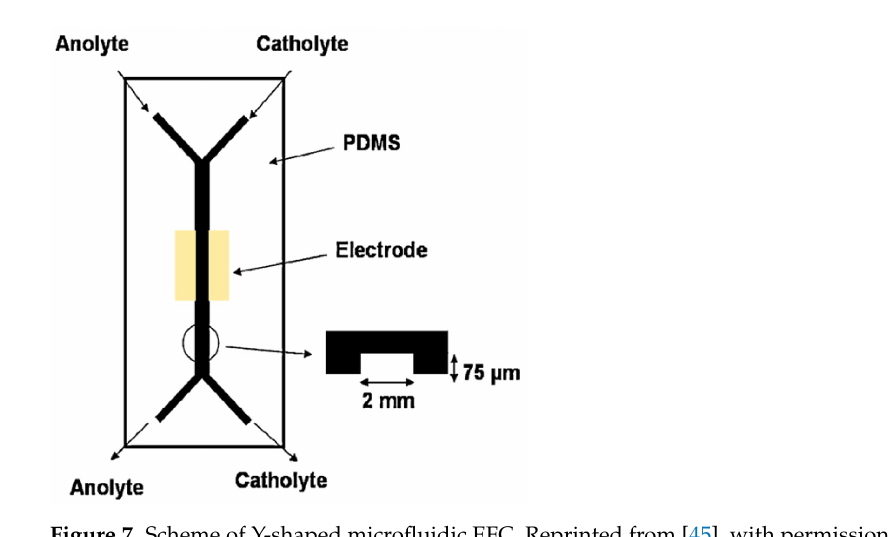
Figure 7. Scheme of Y-shaped microfluidic EFC. Reprinted from [45], with permission from